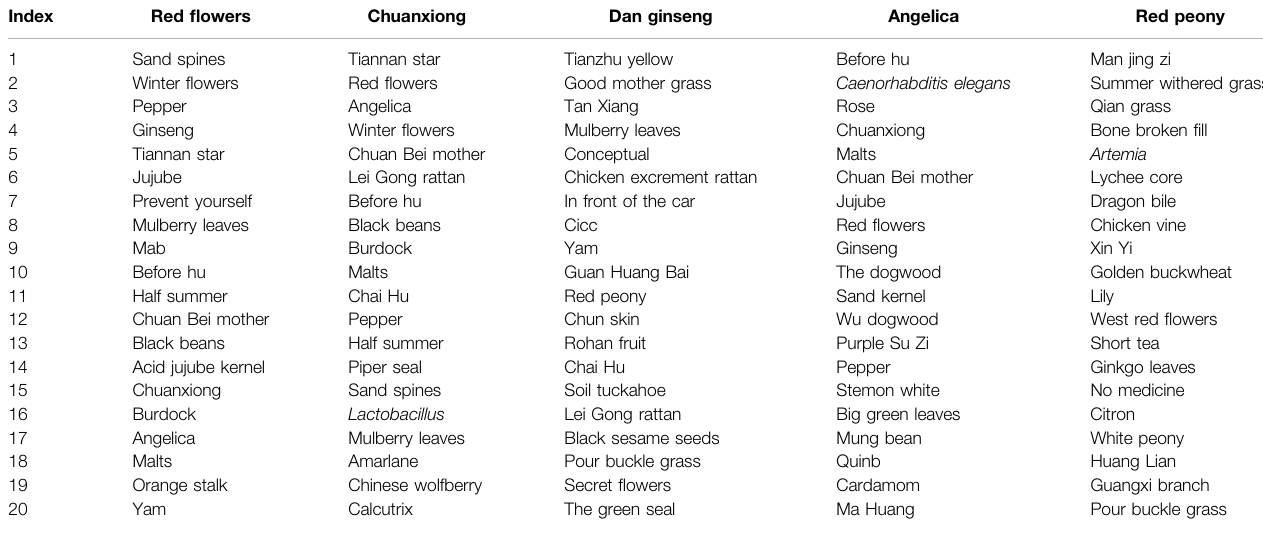
TABLE 5 | Results of collaborative fi ltration of herbal medicine in